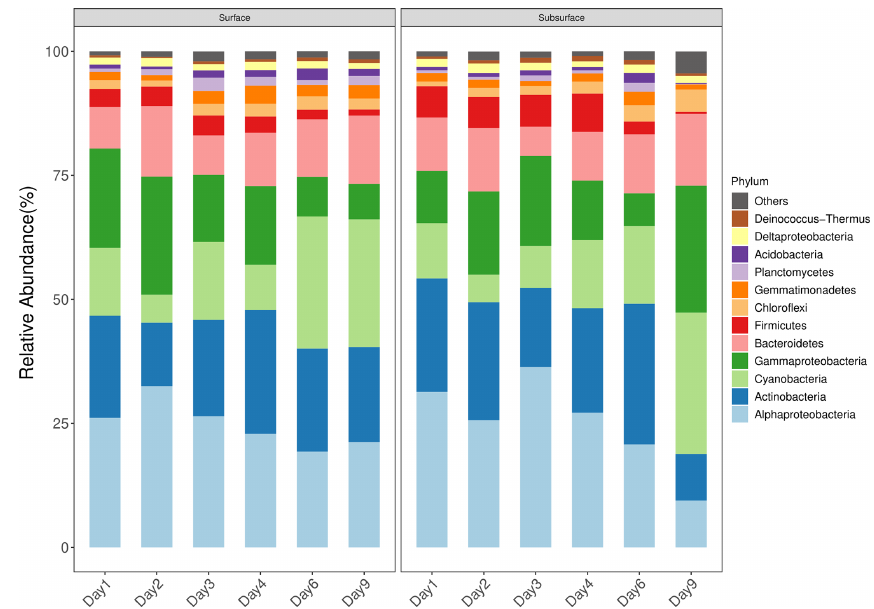
Figure 2. Taxonomic composition of bacterial community in snow. Only dominant phyla are presented (relative abundance > 1%). The snow community are dominated by Alphaproteobacteria, Actinobacteria, Cyanobacteria, Gammaproteobacteria, Bacteroidetes, Firmicutes, Chloroflexi, Gemmatimonadetes, Planctomycetes, Acidobacteria, Deltaproteobacteria, and